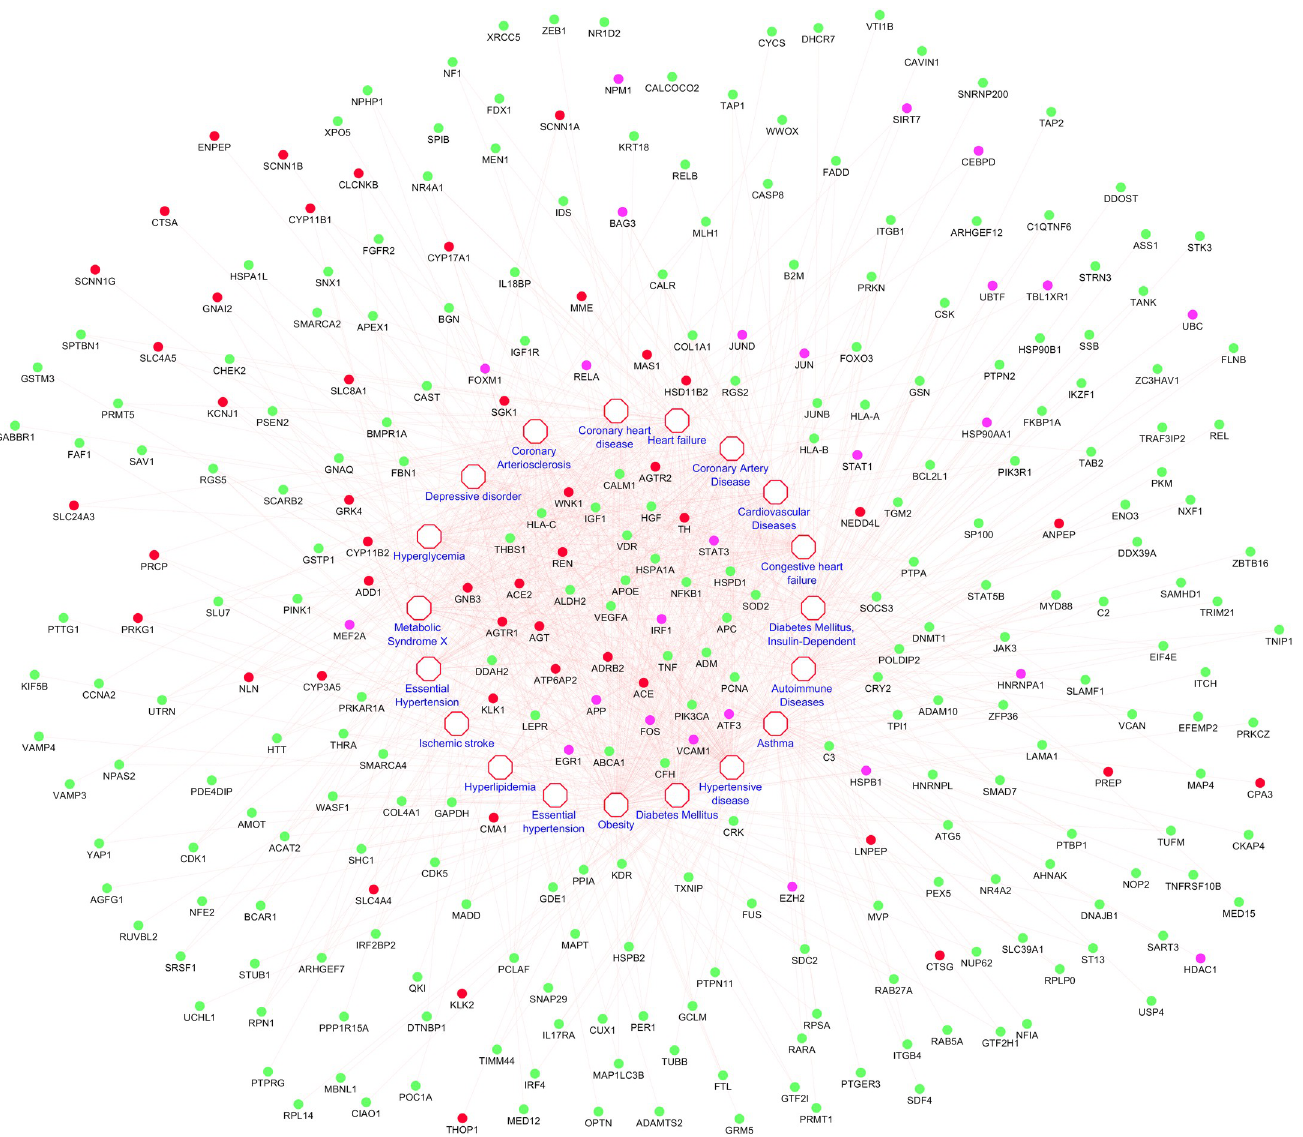
Fig 2. The interaction map of disease to genes. The red nodes represents salt sensitivity genes, pink and green nodes represents hubs and bottlenecks respectively.